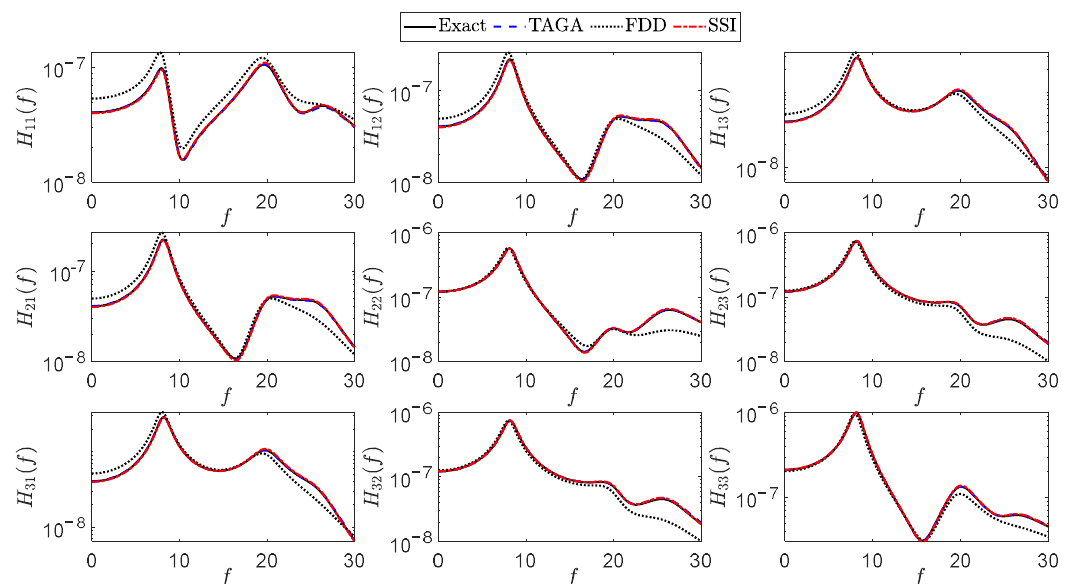
Figure 4. Comparison between the identified FRFs and the exact ones.